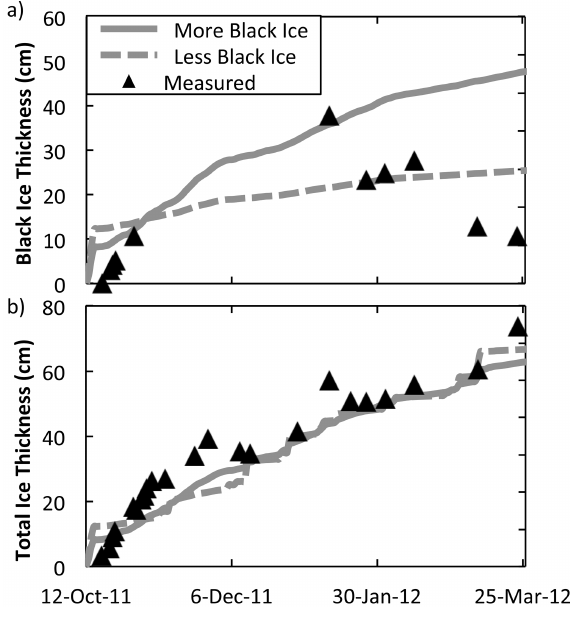
Figure A2. Measured and calculated black (a) and total (white and black, (b) ice thicknesses from the “more black ice” and “less black ice” versions of the model. Snow density was fixed in each version at 300 and 100kgm − 3 ,